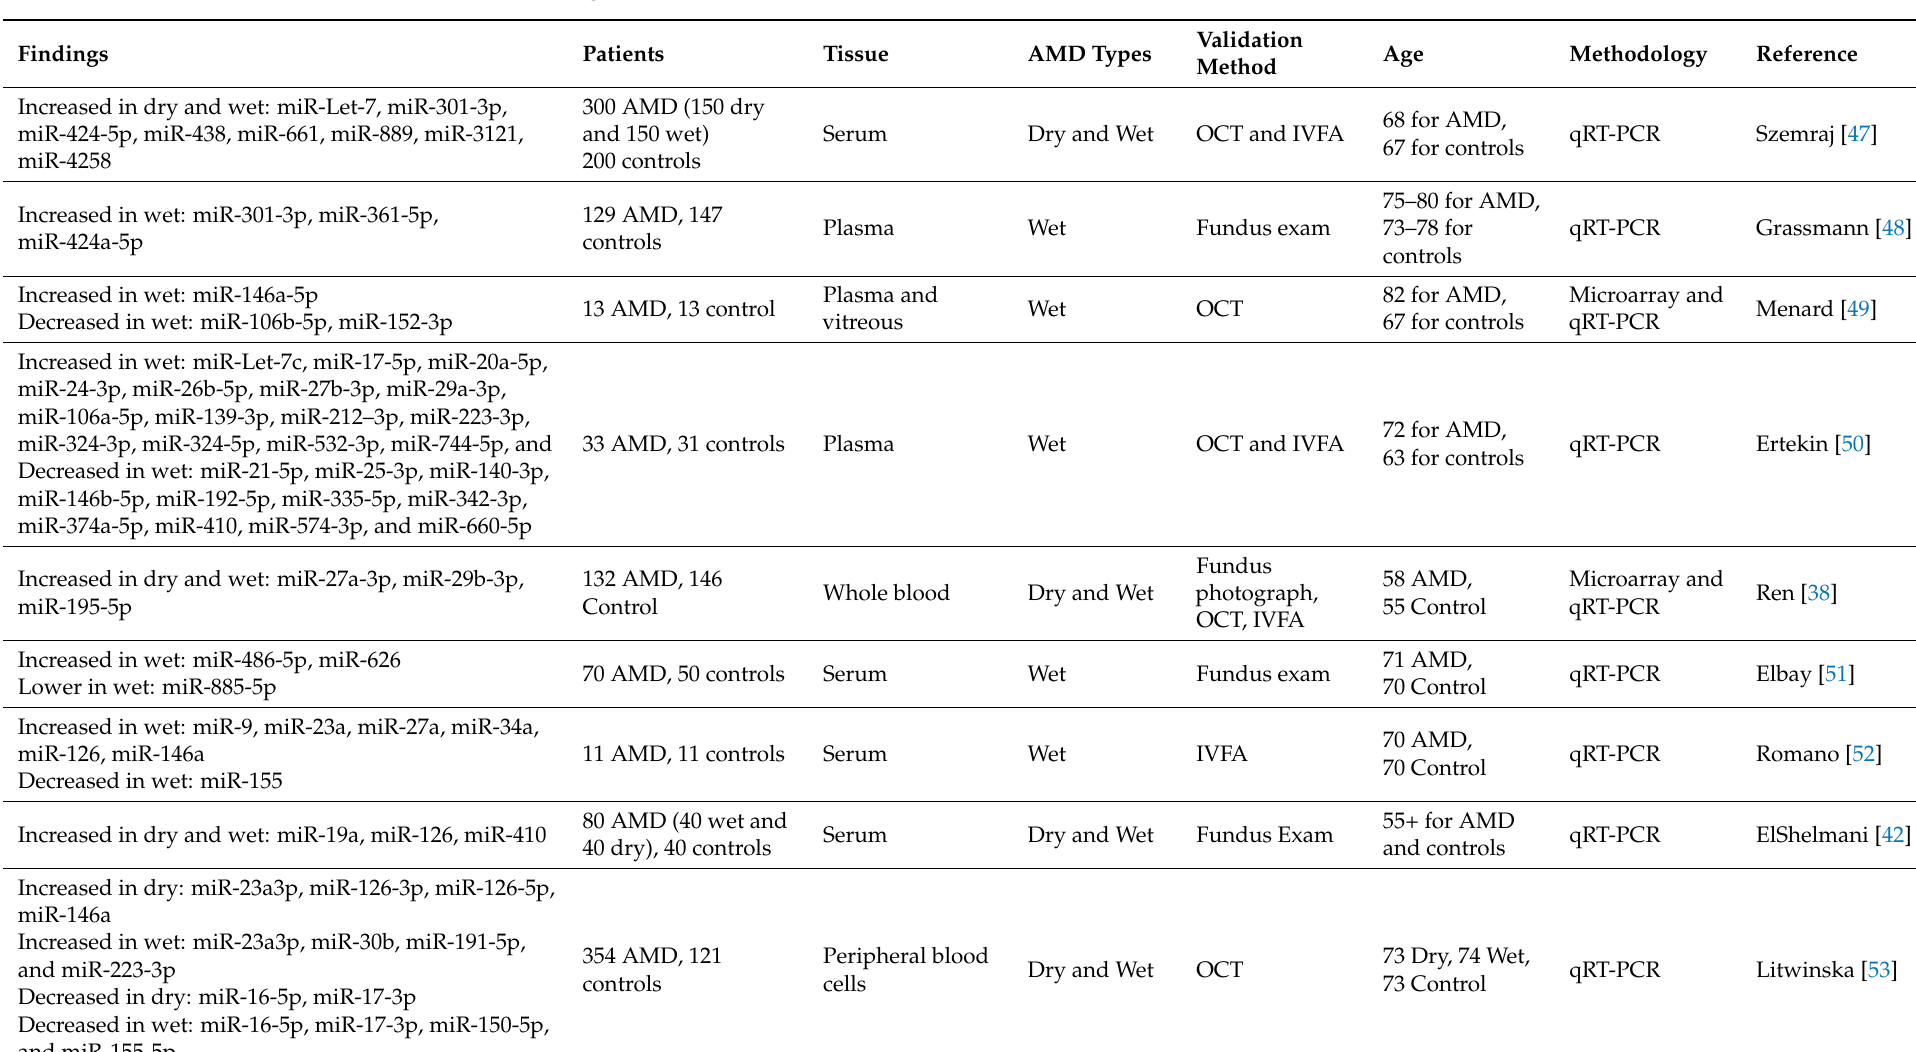
Table 1. Studies Evaluating Micro RNAs as Biomarkers for